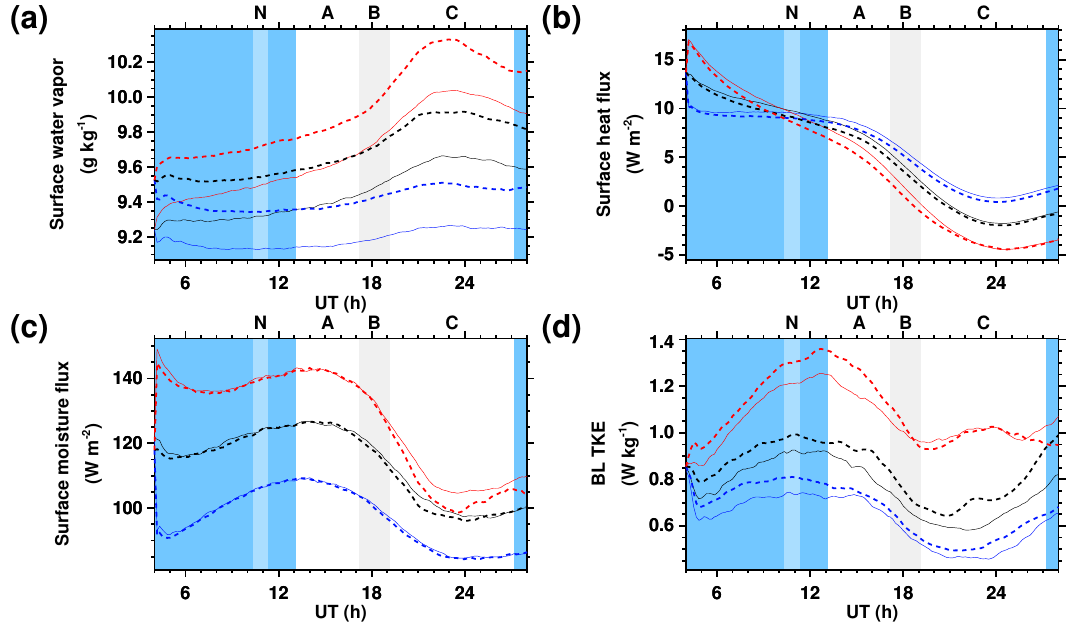
Figure C3. Effect of resolution. Solid curves denote simulations with the base resolution, dashed curves simulations with double resolution in each dimension (Table 2). M − (blue solid), M 0 (black solid), M + (red solid); M − dashed).